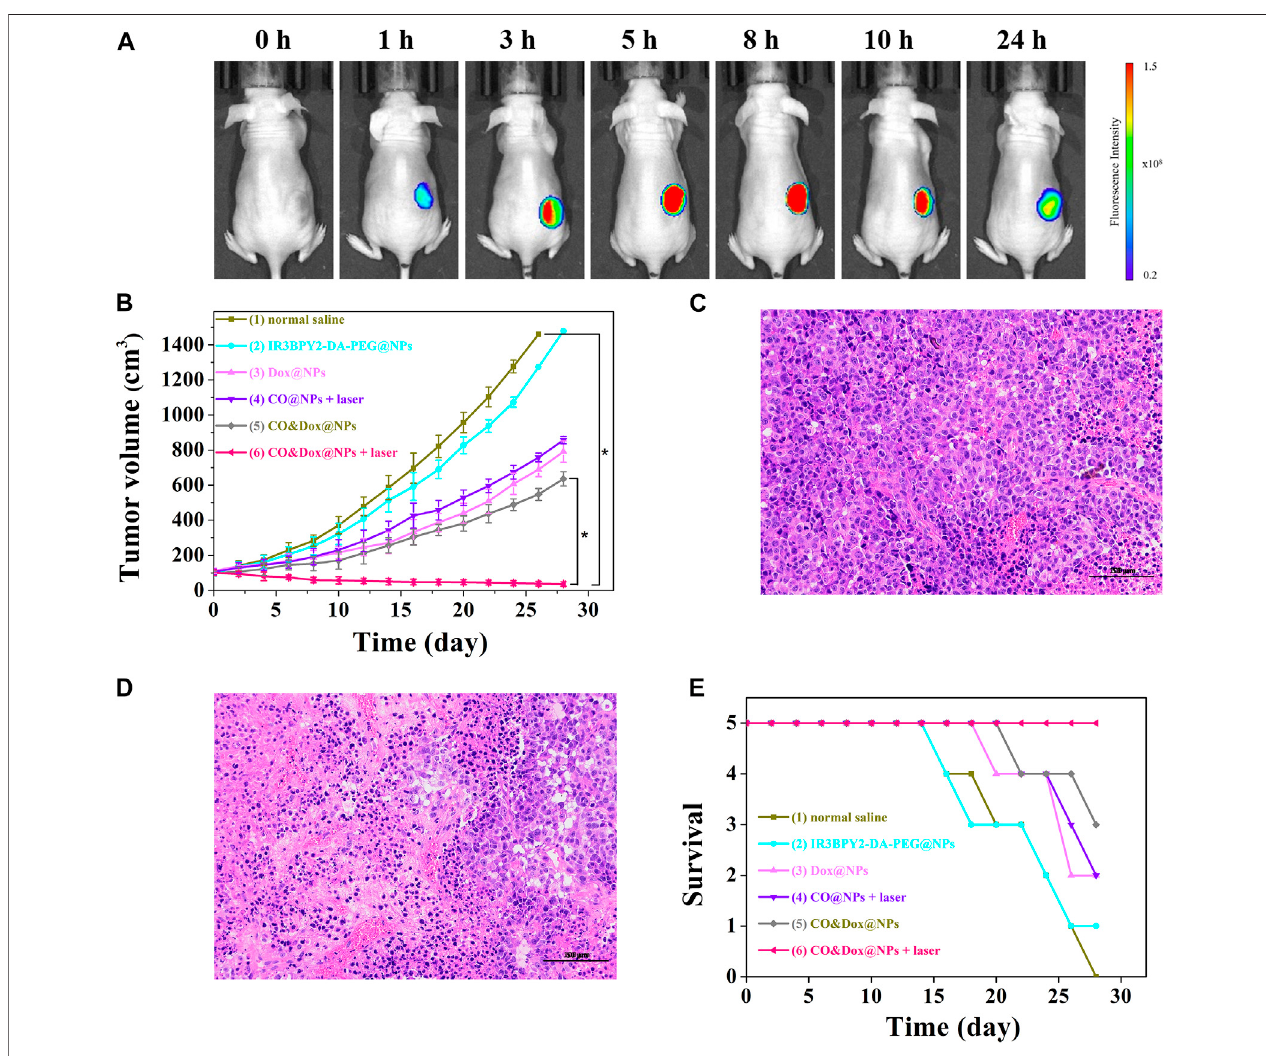
FIGURE 7 | (A) In vivo fl uorescence imaging of tumor bearing mouse before intravenous (i.v.) injection with CO&Dox@NPs and 1, 3, 5, 8, 10, and 24 h post i.v. injection with CO&Dox@NPs. (B) Tumor volumes of mice receiving different treatments; (C) Pathological section of tumor tissue from group (1) via H&E staining; (D) Pathological section of tumor tissue from group (6) via H&E staining. Scale bars: 50 μ m; (E) Survival curves of mice in each group ( n (cid:2) 5 each group). Each mouse was intravenously injected with normal saline (100 μ l) (1), IR 3 BPY 2 -DA-PEG@NPs (200 mg/kg) (2), Dox@NPs (200 mg/kg) (3), CO@NPs (200 mg/kg) (4), CO&Dox@ NPs (220 mg/kg) (5), CO&Dox@NPs (220 mg/kg) (6), and groups 4 and 6 were treated with 808 nm laser for 10 min at 6 h post the incubation. * p < 0.001.